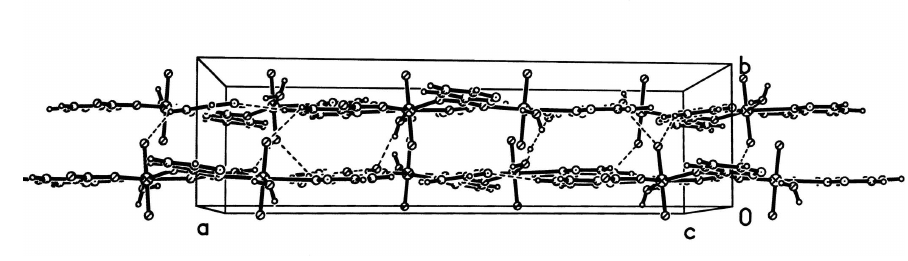
Figure 2 Packing diagram of the crystal